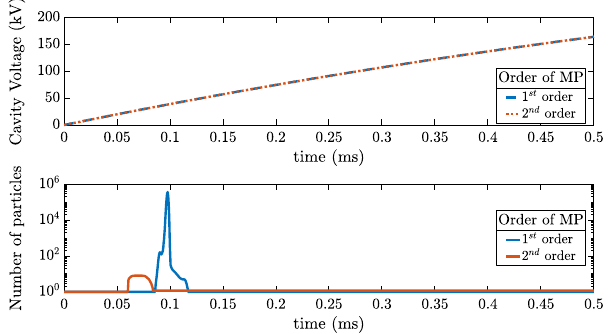
FIG. 20. Cavity voltage and the number of secondary electrons as a function of time: 1st and 2nd order multipacting with the maximum coupling, availiable power of 4 kW, and adjusted SEY for Nb.